Question: Based on the figure, does the quantity rise or fall?
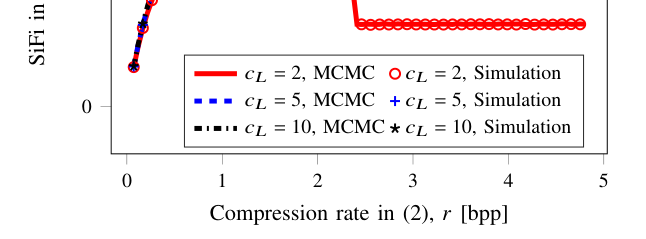
Answer: increasing